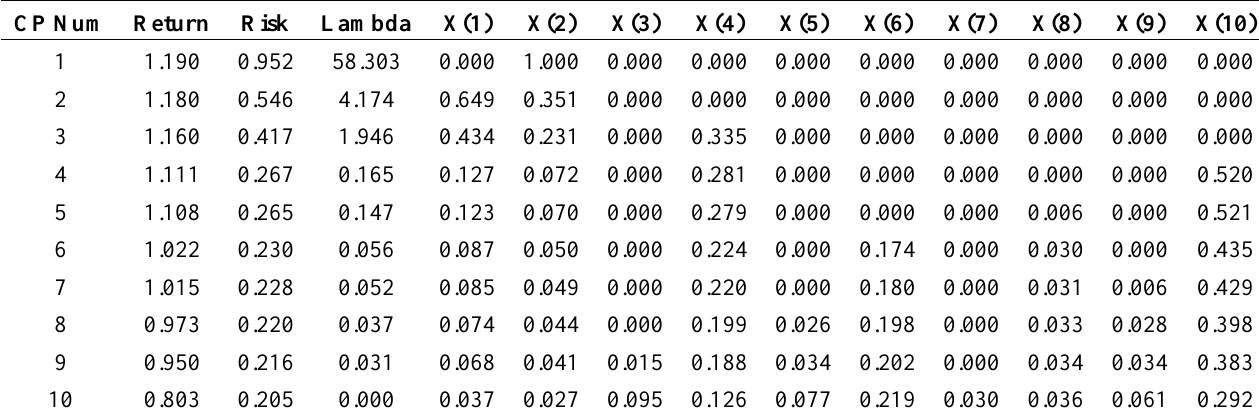
Table 2. Return, Risk, λ and composition of the 10 turning points.